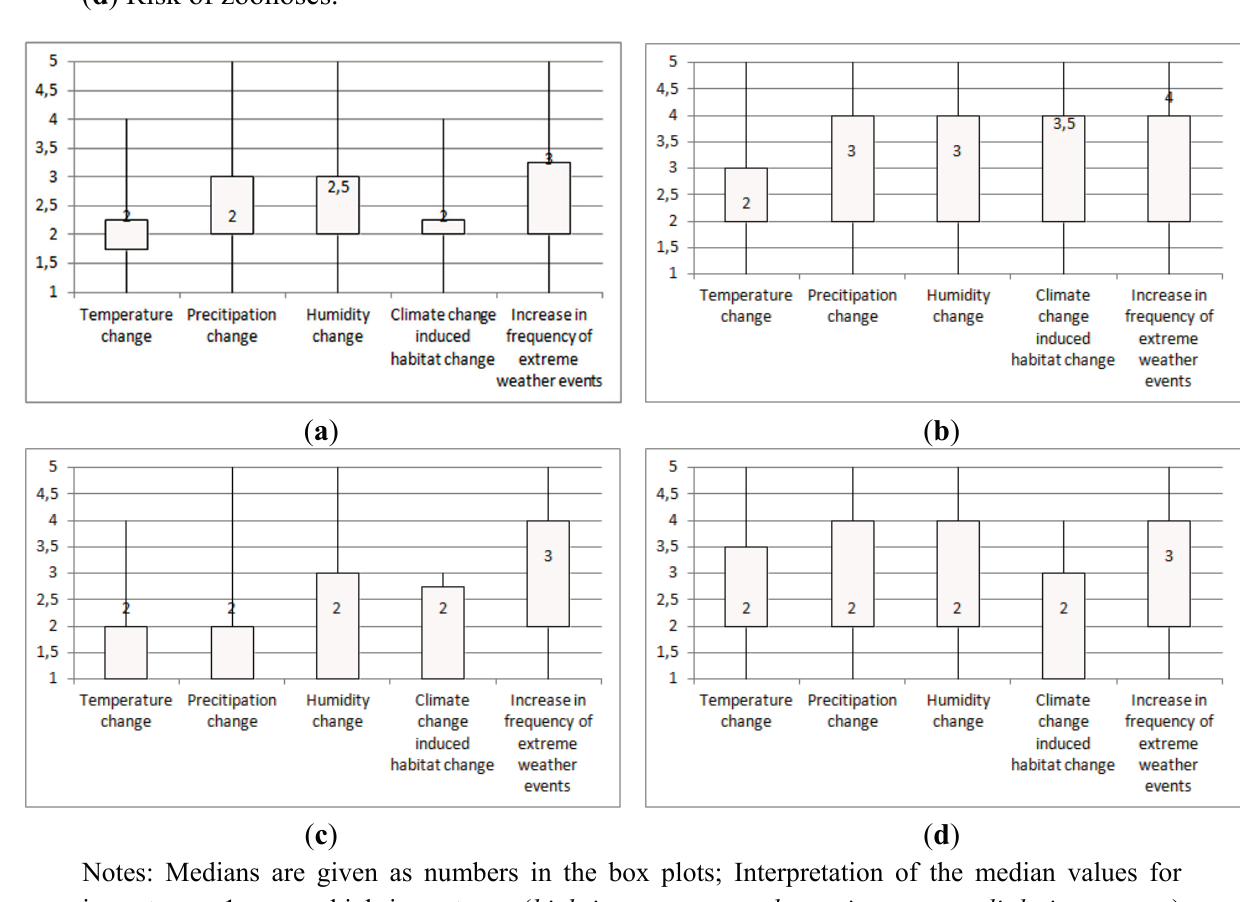
Figure 1. Box plots of the aggregate sample assessment of the relative importance of climatic drivers for each type of infectious disease risk ( a ) Water-related infectious disease risk; ( b ) Food-related infectious disease risk; ( c ) Vector-borne disease risk (excluding zoonoses); ( d ) Risk of